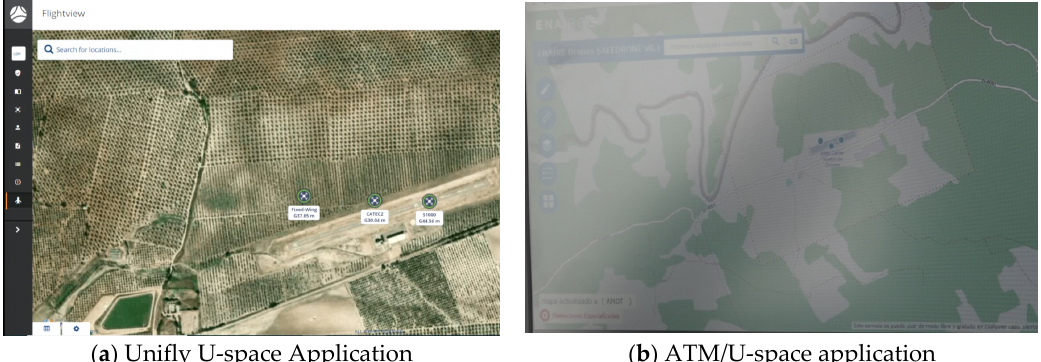
Figure 10. Monitoring of drones in different platforms. ( a ) U-space application implemented by the Unifly company, and ( b ) Screenshot of the ATM HMI that monitors the information sent by U-space. While drones were performing their operations, a manned aircraft without any tracking device needed to enter VLL airspace. In this case, the proposed procedure was that the crew informed ATM about the intent to operate in VLL airspace and the expected area of operation or, at least, its approximated position. In this case, the ATCos’ predefined action consists of creating a temporary geofence that covers the entire zone where the manned aircraft is operating. This geofence was then received by U-space and displayed to their users. In this situation, operators whose drones were inside the new temporary no-fly zone were alerted, so they were obliged to start the defined contingency procedure in order to avoid the manned aircraft. Once the manned aircraft left VLL airspace, the ATCo removed the geofence, and the drones’ missions were resumed. Figure 11 show these steps in the different applications in a graphical manner. ( a ) Creation of a Geofence from ATM. ( d ) Geofence is removed. Figure 11. Illustration of the steps followed in the first scenario where the proposed procedure was that the crew informed ATM about the intent to operate in VLL airspace and the expected area of operation. In this case, the ATCos’ predefined action consists of creating a temporary geofence that covers the entire zone where the manned aircraft is operating.